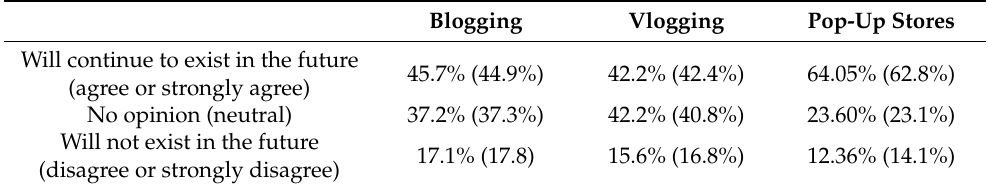
Table 7. New profession sustainability by type of new professional service. Numbers in brackets refer to the 18–34 years of age customer